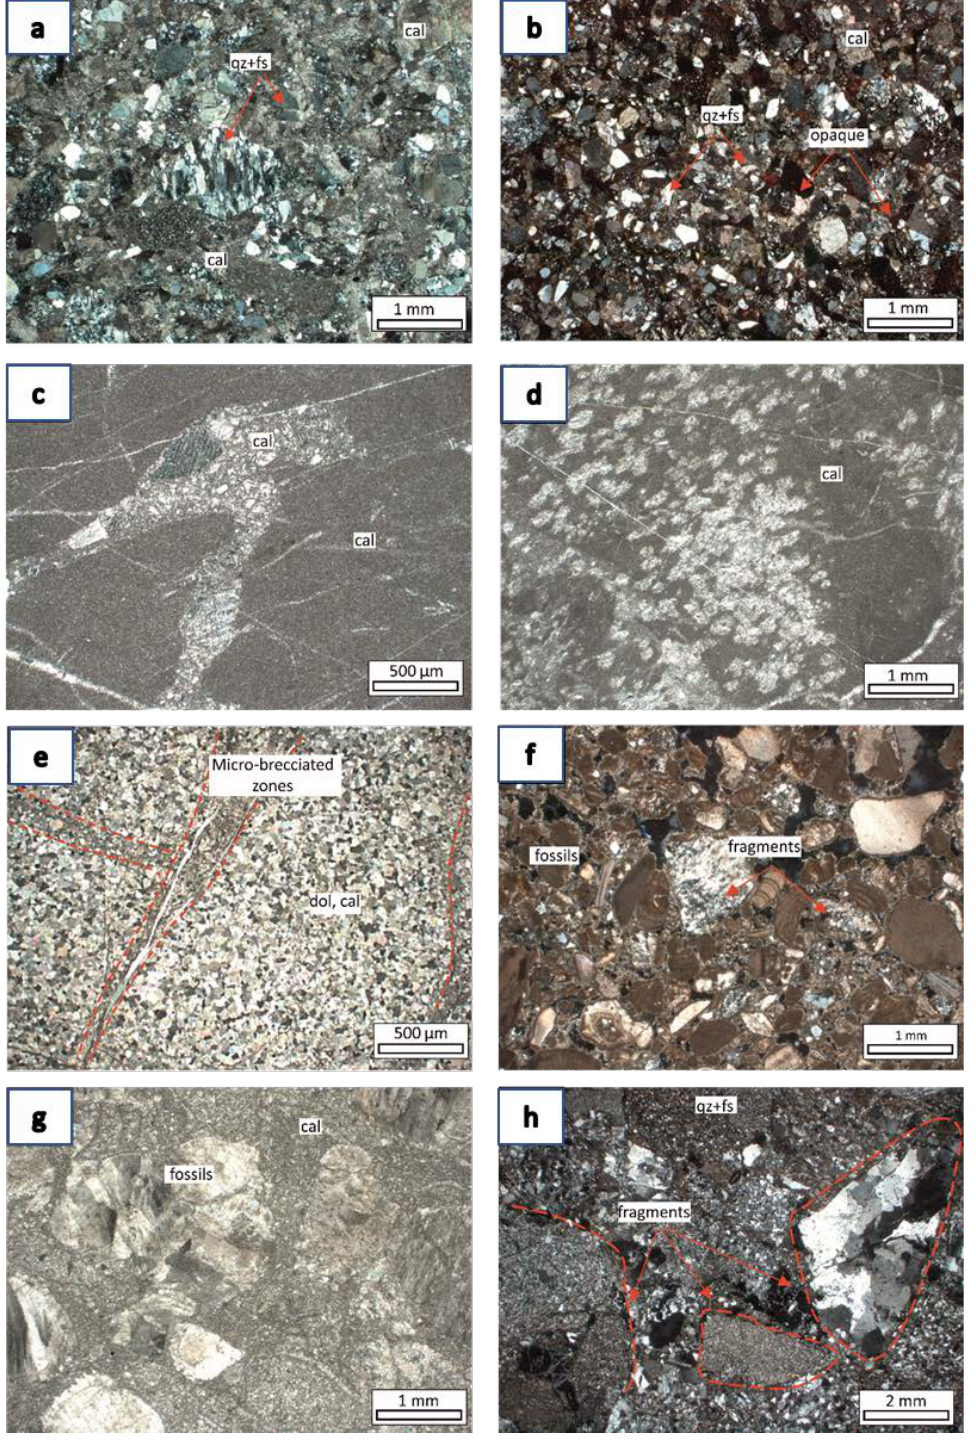
Figure 8. Representative photomicrographs of the studied samples: ( a , b ) sandstone specimens (samples AST6, AST7); ( c ) coarse-grained calcite crystals filling micro-veins in micritic limestone (sample AST25); ( d ) micritic limestone with the characteristic grumeleuse texture (sample AST13); ( e ) brecciated zones in coarse-grained limestone (sample AST26); ( f ) biomicrite comprising a variety of fossils and clastic fragments (sample AST9A2); ( g ) biosparite, comprising fossils and sparitic calcite (sample AST4B); ( h ) breccia lithotype characterized by subangular fragments, in fine-grained groundmass of quartz and feldspars (sample AST4A). Mineral abbreviations are according to [44]: calcite (cal); dolomite (dol); feldspars (fs); quartz (qz).